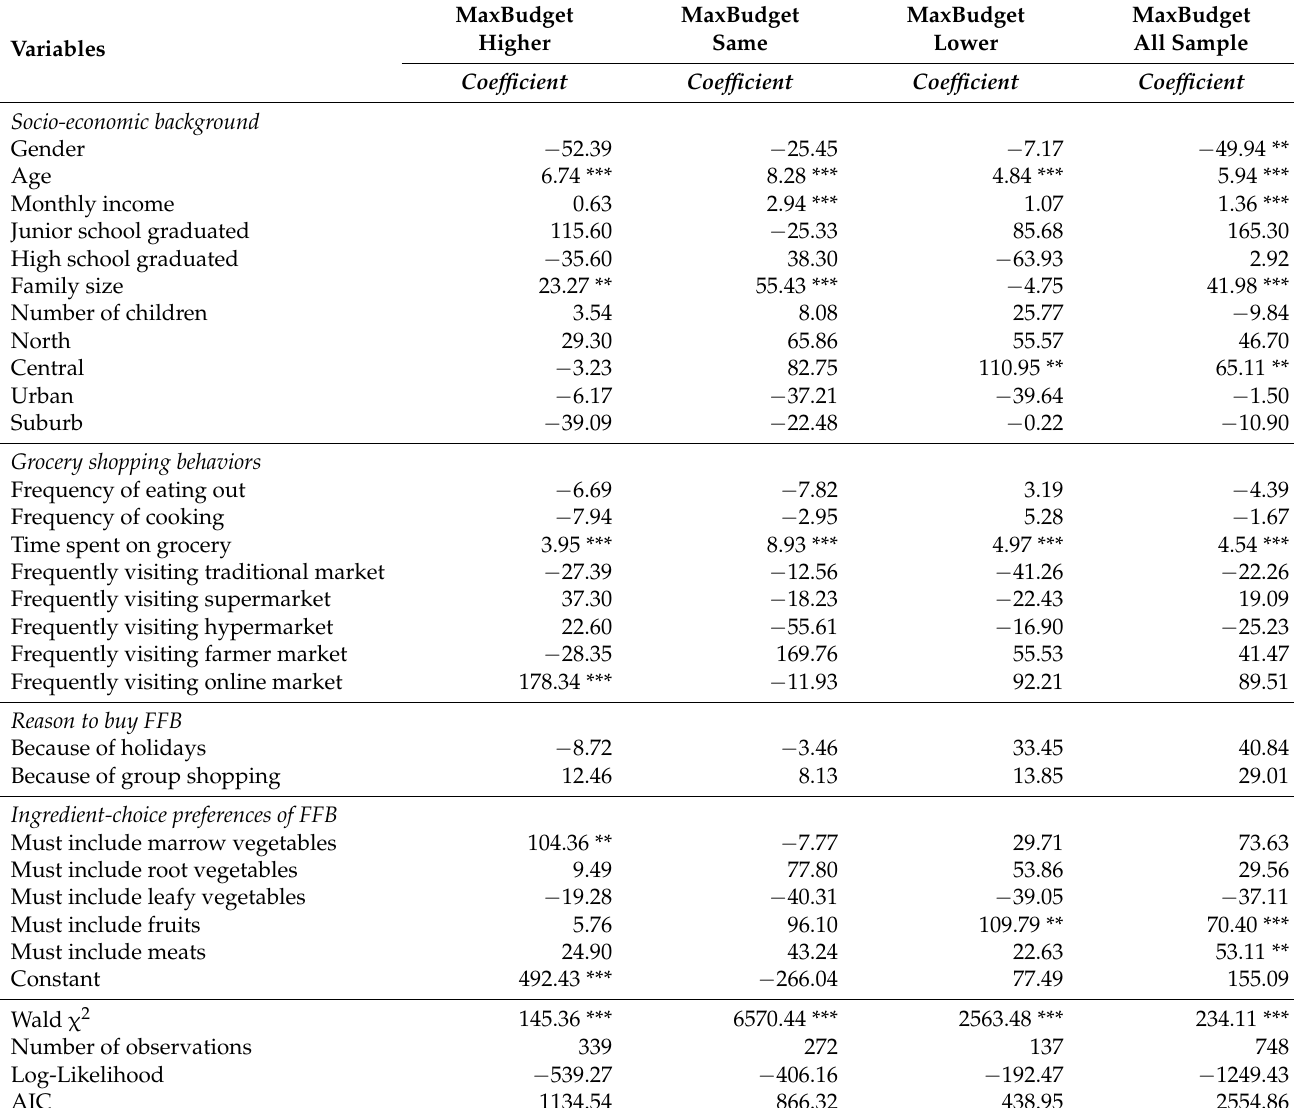
Table 2. The Estimated Outcomes of the Interval Regression Models ( n =